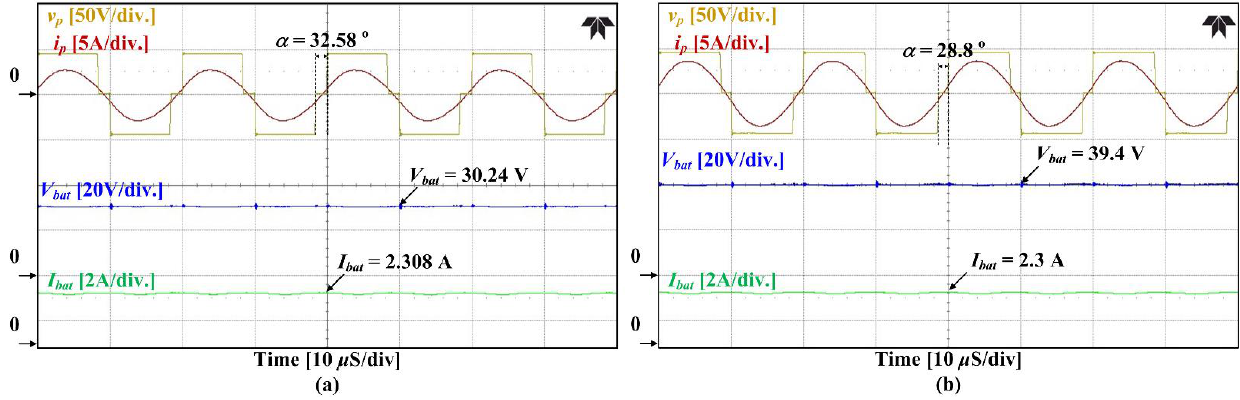
Figure 10. Experimental waveforms when the proposed WPT circuit operates in the CC mode with f s = f o at ( a ) R bat = 13.04 Ω, and ( b ) R bat = 17.04 Ω.